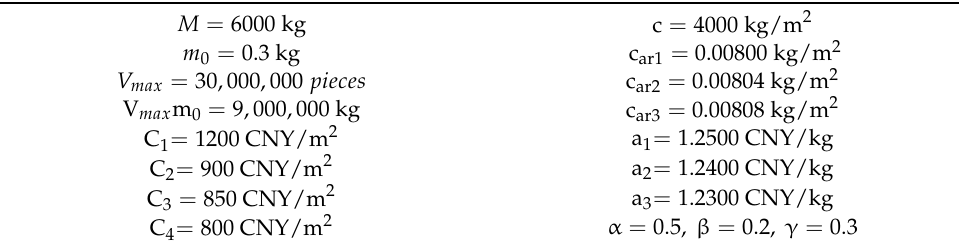
Table 3. The parameters given in this paper and their